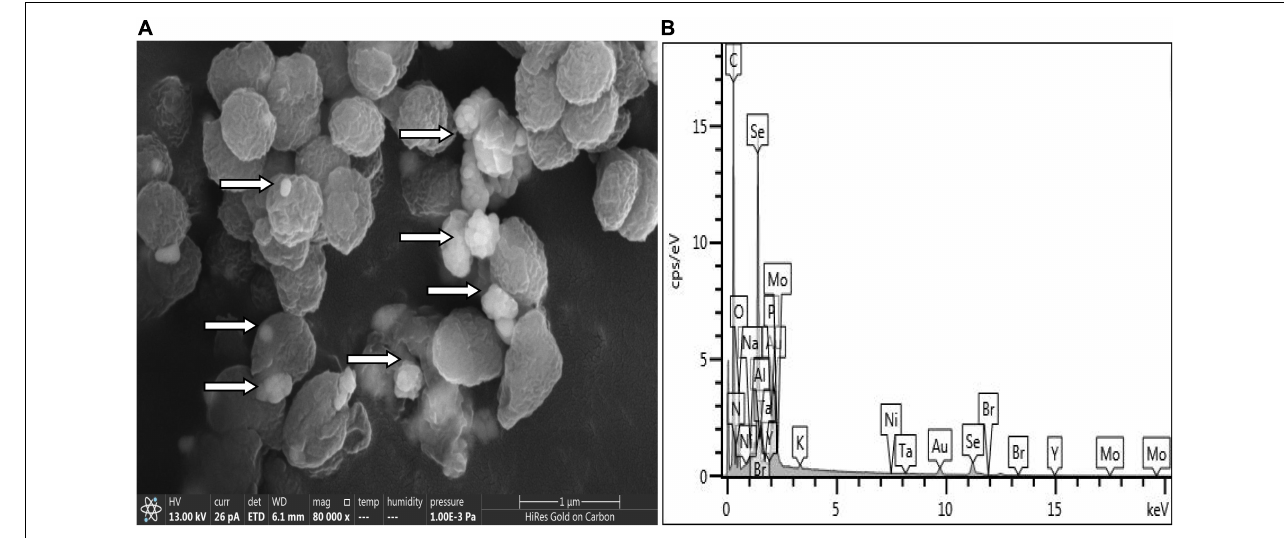
FIGURE 6 | Scanning electron microscopy (SEM) (A) and EDX (B) analysis of Proteus mirabilis QZB-2 cultures grown in presence of 2 mM selenite.